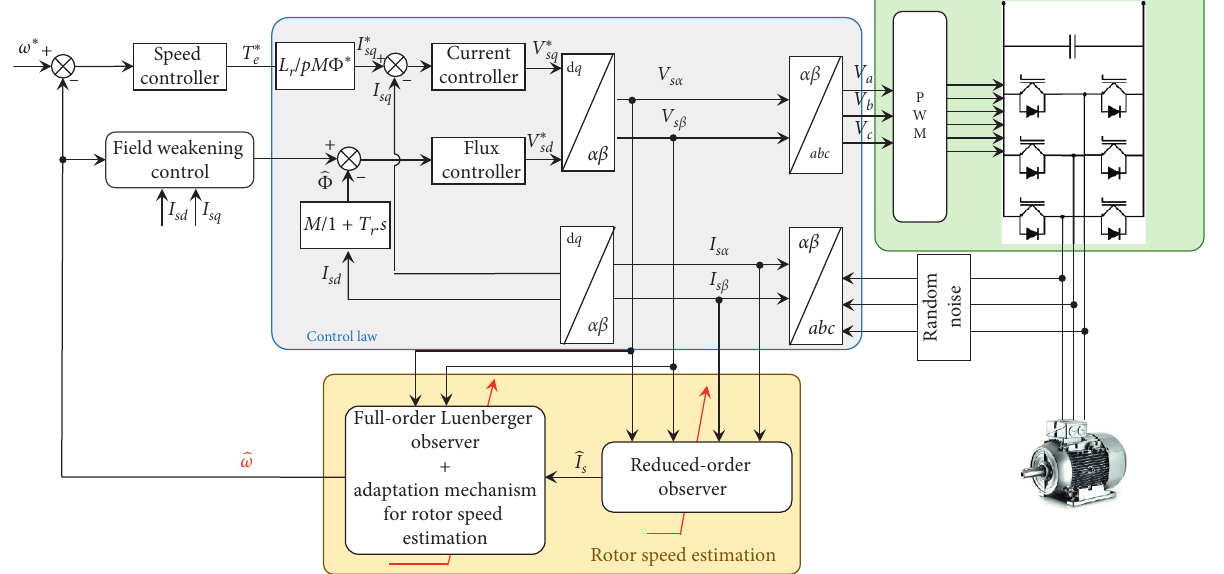
Figure 6: Sensorless vector control using a cascade structure of the full-order Luenberger and the reduced-order